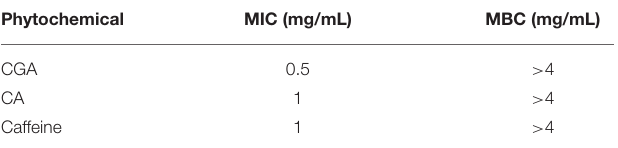
TABLE 5 | The MIC and MBC values of coffee phytochemicals of the V. cholerae O1 El Tor N16961.